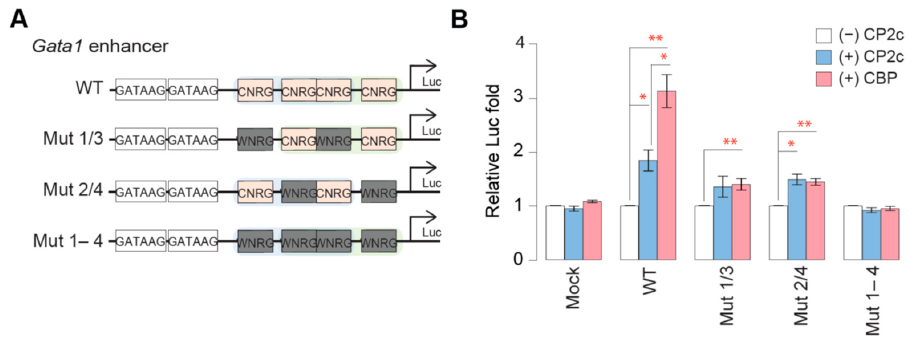
Figure 7. tCP2c exerts a pioneering function for recruiting [C2B2P2] 2 to the CP2c binding sites with three or more CP2c half-sites. ( A ) Experimental scheme to test binding efficiency of CP2c complex proteins in vitro by Western blot analysis. ( B – D ) Immunoblots and estimated dissociation constant (Kd) and DNA binding efficiency of [C4] and [C2B2P2] 2 in probes containing the Gata1 enhancer ( B ), the Hba-a2 promoter Mut 4 ( C ), and the Hba-a2 promoter Mut 3/4 ( D ). See Figure S1 for additional data for binding efficiency to other biotin-labeled probes.